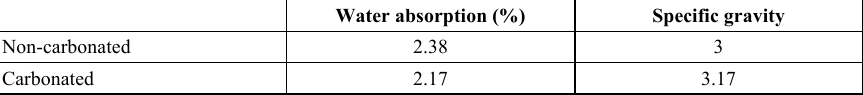
Table 2. Physical properties of carbonated and non-carbonated RA